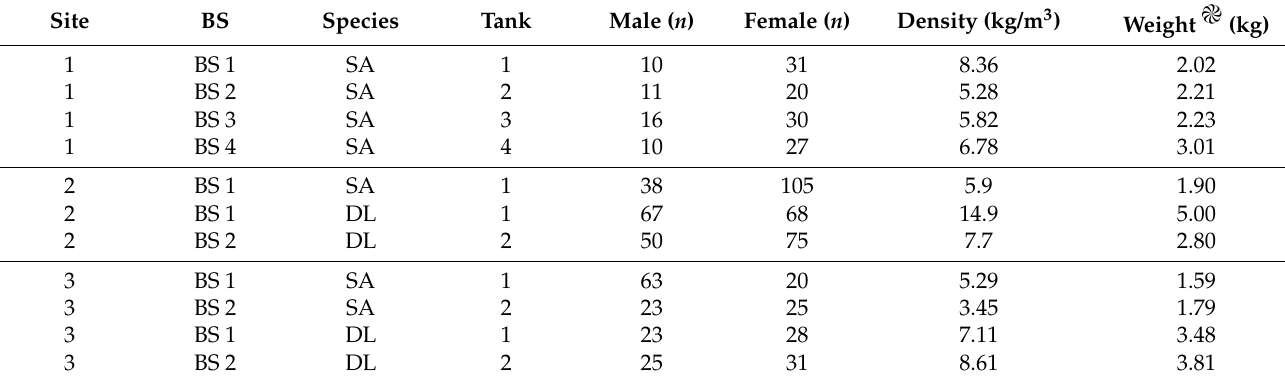
Table 1. Broodstock characteristics and conditions (linked to Figure 1).